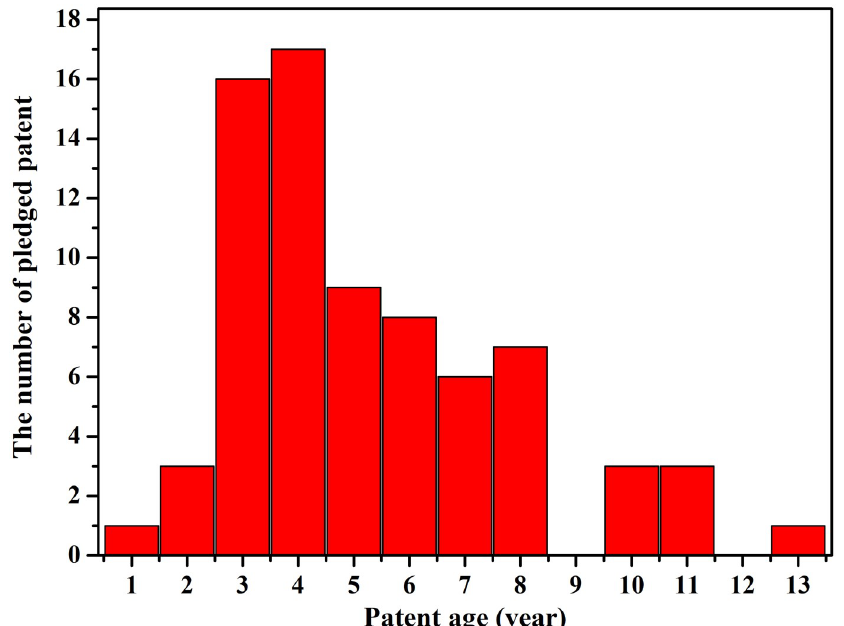
Fig 4. The distribution of age of pledged patents.